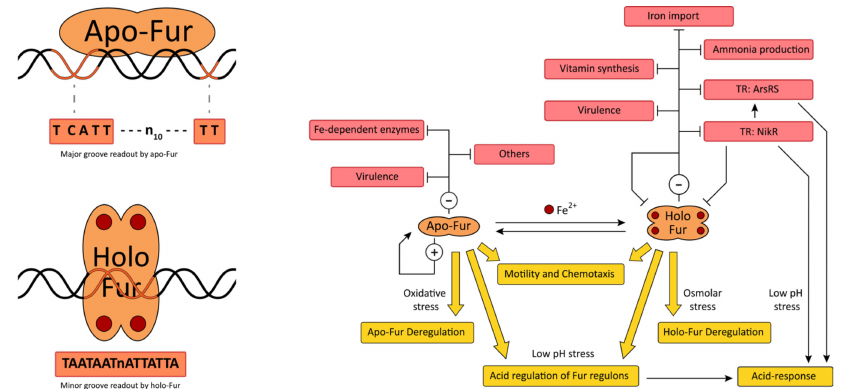
Figure 3. Schematic representation of Fur regulation in H. pylori . On the left part of the figure, a cartoon representation of the apo-Fur homodimer, holo-Fur homo-tetramer with the Fe 2+ -mediated (filled red circles) transition to holo-Fur, and their operator consensus sequences reported underneath, respectively. On the right part of the figure, the network connects apo- and holo-Fur to their target sets of genes. Symbols are as indicated in the legend in Figure